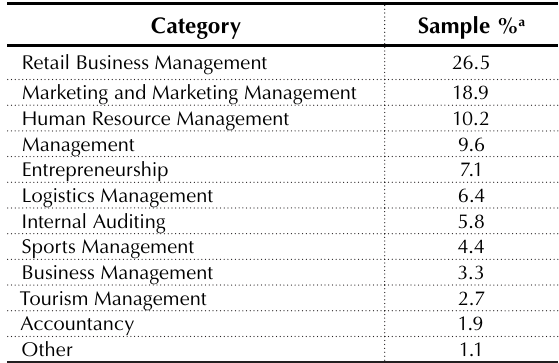
Table 2. Current field of